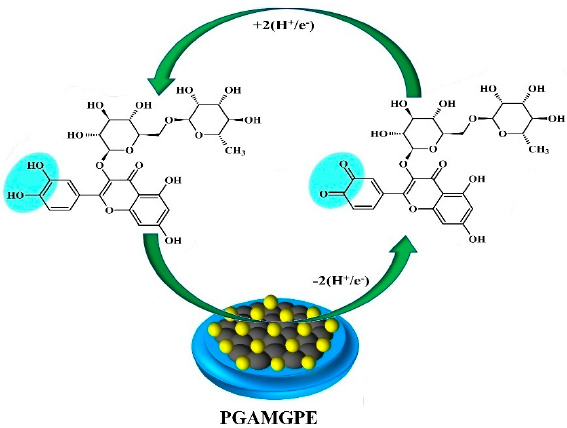
Figure 5. ( a ) CV response of 0.1 mM RU at PGAMGPE in 0.2 M PB of pH ranging from 5.5 to 8.0. ( b ) Plot of E pa versus Ph. ( c ) Plot of I pa versus pH of solution.